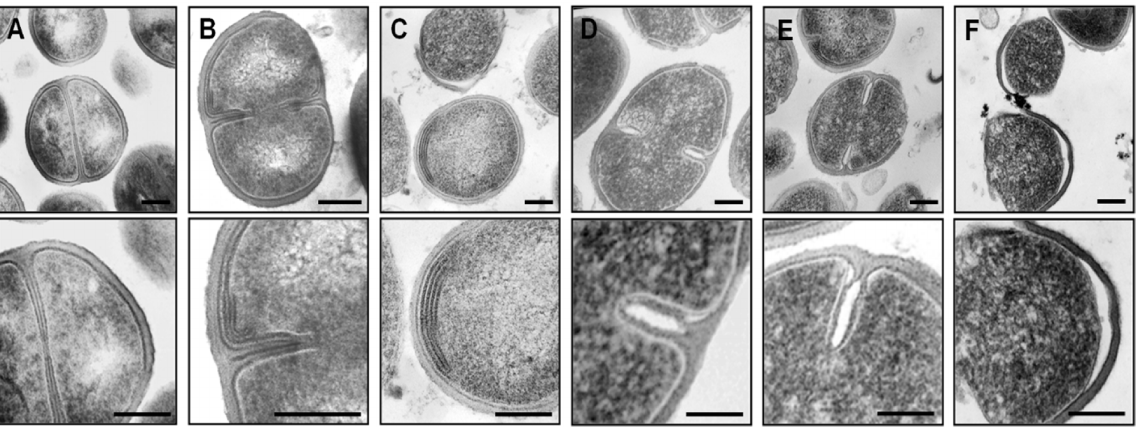
Figure 4. Transmission electron microscopy of S. aureus SG511-Berlin treated with 10× MIC RTD-2. (A) Untreated control cells. (B,C) Cells treated for 30 min. Additional membranous structures could be observed. (D,E,F) Cells treated for 60 min. Dividing cells showed degradation of the cell wall in the septum area between two daughter cells (D,E) or peeling of the cell wall (F). Scale bar: 0.2